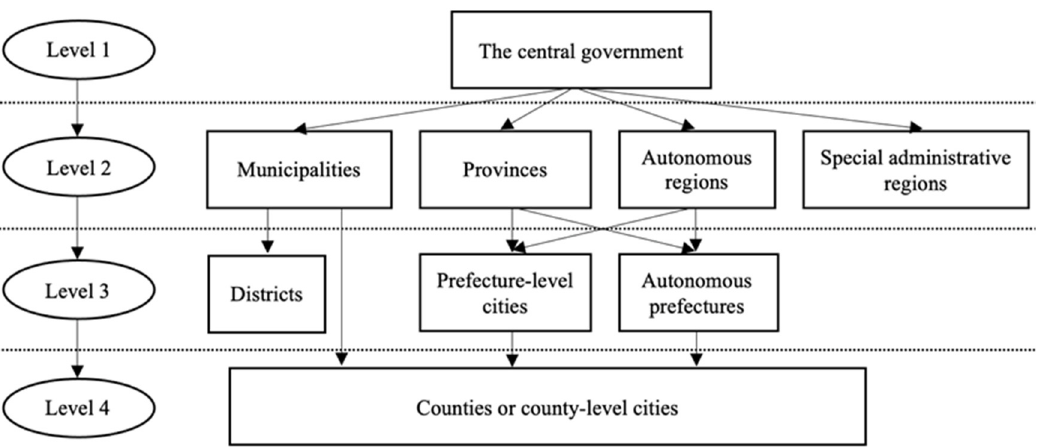
Figure 2. The Chinese political hierarchy above the county level.